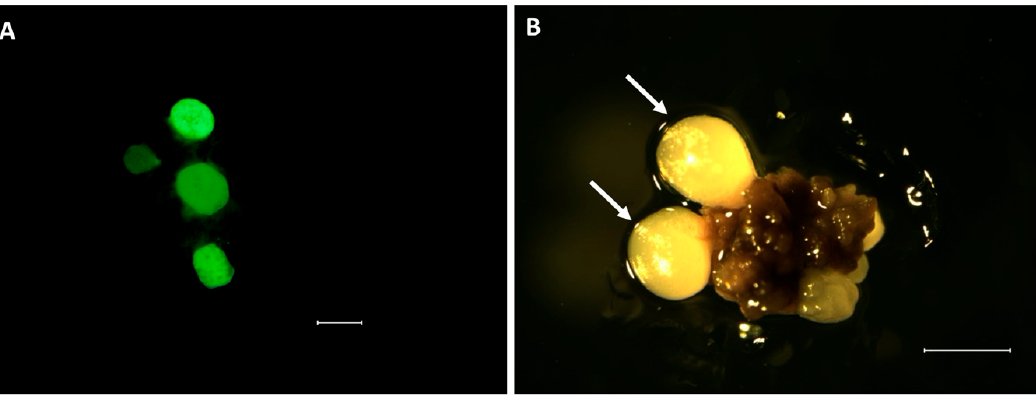
Figure 6. American chestnut somatic embryos transformed with Agrobacterium AGL-1 strain after 5 weeks in selection medium. ( A ) Positive control: Ellis #1 transformed with pFHI_GFP observed under ultraviolet light. ( B ) AxW3 transformed with pFHI_Gnk2. Arrows indicate putative events. Bar = 1 mm.